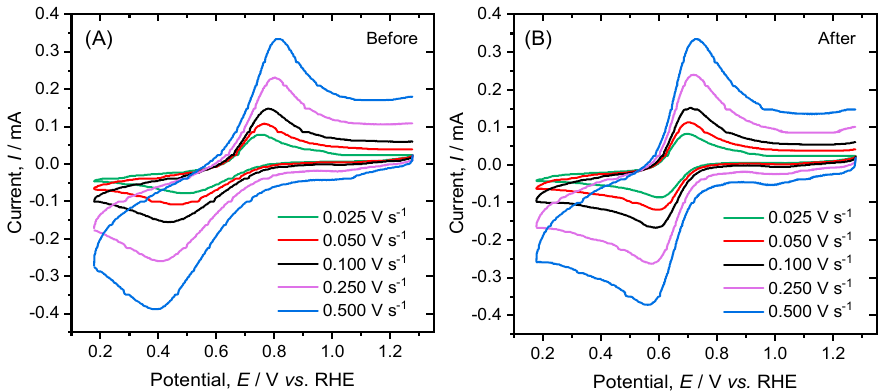
Figure 5. CVs at different scan rates for surface coverage analysis of Au disc electrode before ( A ) and after ( B ) coating with [Mo 3 S 7 (S 2 CNMe 2 ) 3 ]I in THF. Electrolyte: 1 mM K 3 Fe(CN) 6 in 0.1 M KNO 3 .